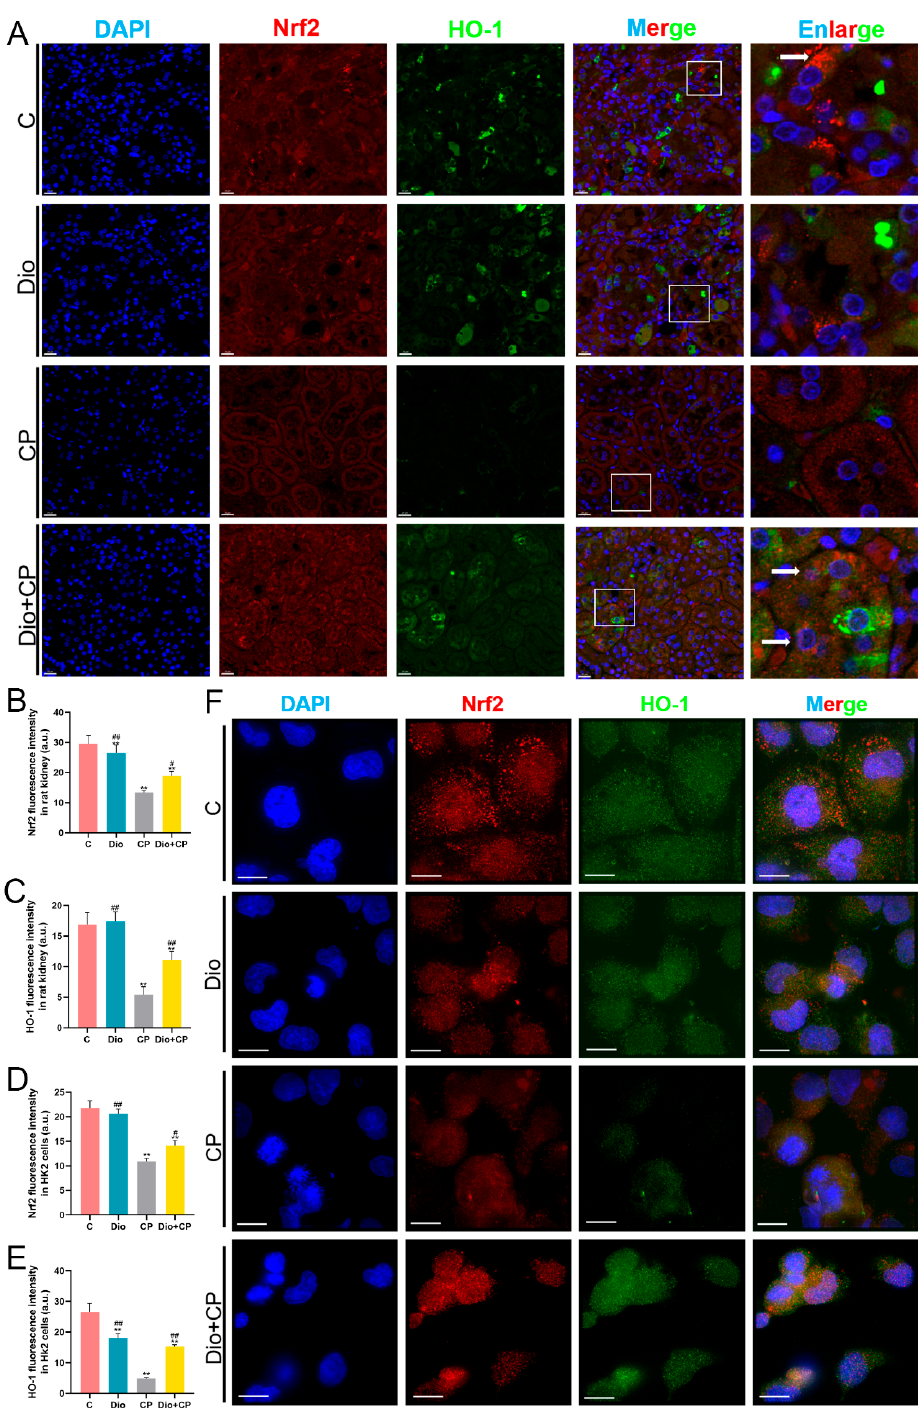
Figure 5. Dioscin upregulates Nrf2/HO-1 signaling in cisplatin-treated rat kidney and HK2 cells. ( A – C ) Representative images and quantification of Nrf2 and HO-1 immunofluorescence (scale bar = 20 μ m) in rat kidneys (n = 5). ( D – F ) Representative images and quantification of Nrf2 and HO-1 immunofluorescence (scale bar = 15 μ m) in HK2 cells (n = 5). C, control group; Dio, dioscin group; CP, cisplatin group; Dio + CP, dioscin + cisplatin group. Results are presented as Mean ± SD. Statistical significance was obtained by one-way ANOVA. ** p < 0.01 compared with C group. # p < 0.05, ## p < 0.01 compared with CP